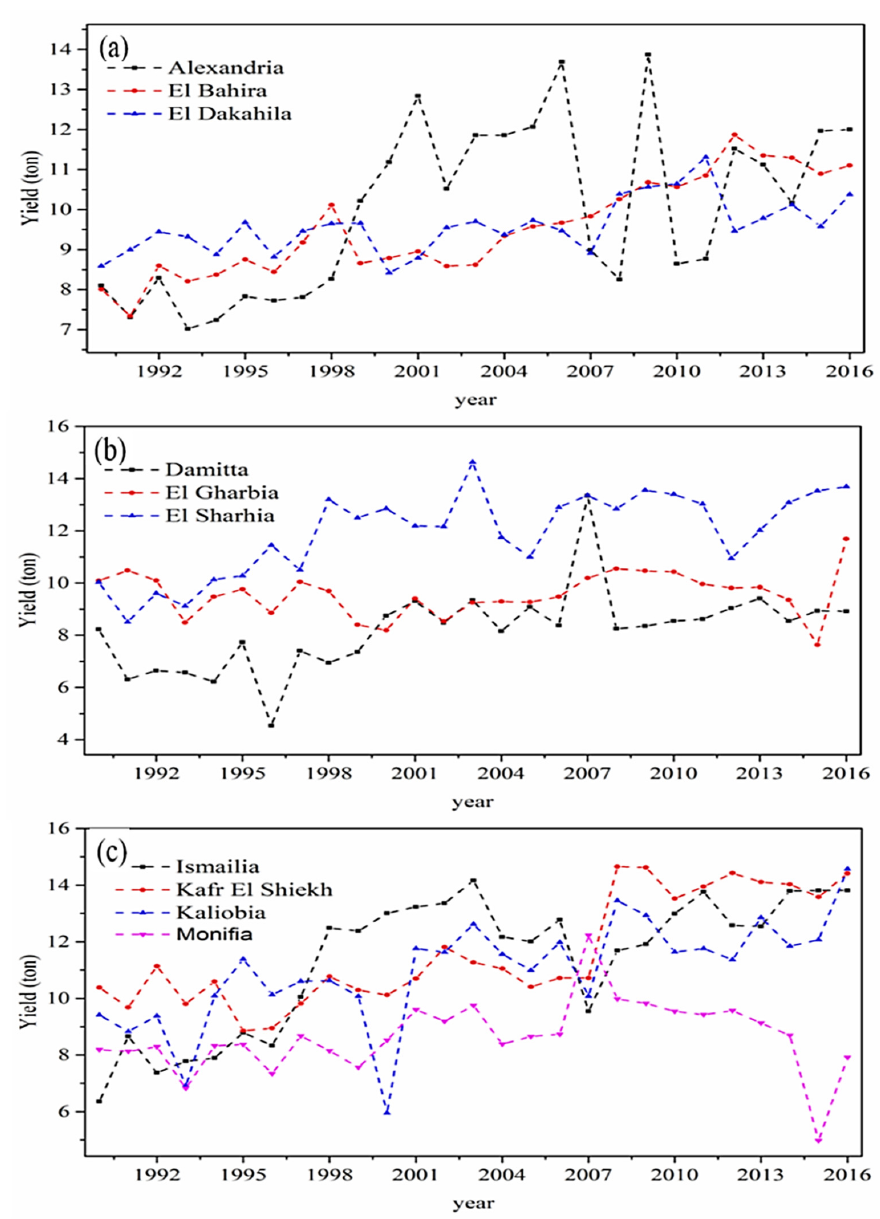
Figure 5. Time evolution of the potato yield in the 10 governorates from 1990 to 2016.